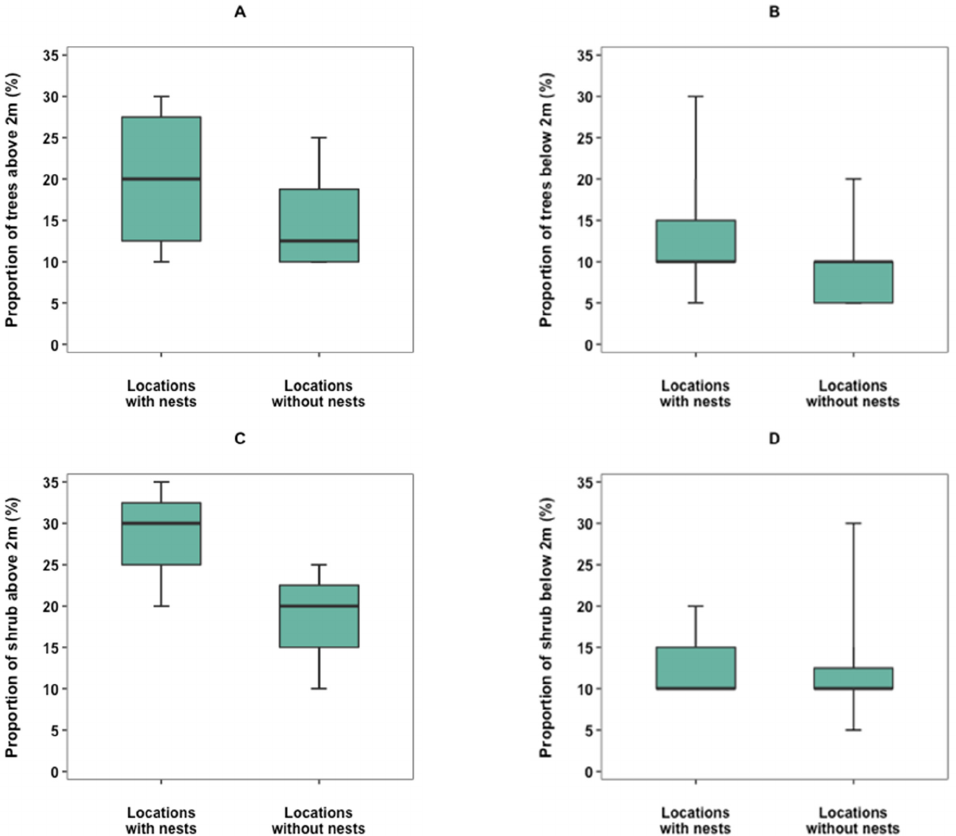
Figure 5. Boxplots exhibiting the proportion of ( A ) trees above 2 m, ( B ) trees below 2 m, ( C ) shrubs above 2 m, and ( D ) shrubs below 2 m within 5 m of the nest box. Locations with findings of hazel dormouse nests (n = 12) are compared to locations without findings of hazel dormouse nests (n = 12). Boxes represent the 25 to 75% interquartile range, and the lines are the median values. Error bars extend upward from the third quartile to the maximum and the other extends downward from the first quartile to the minimum.